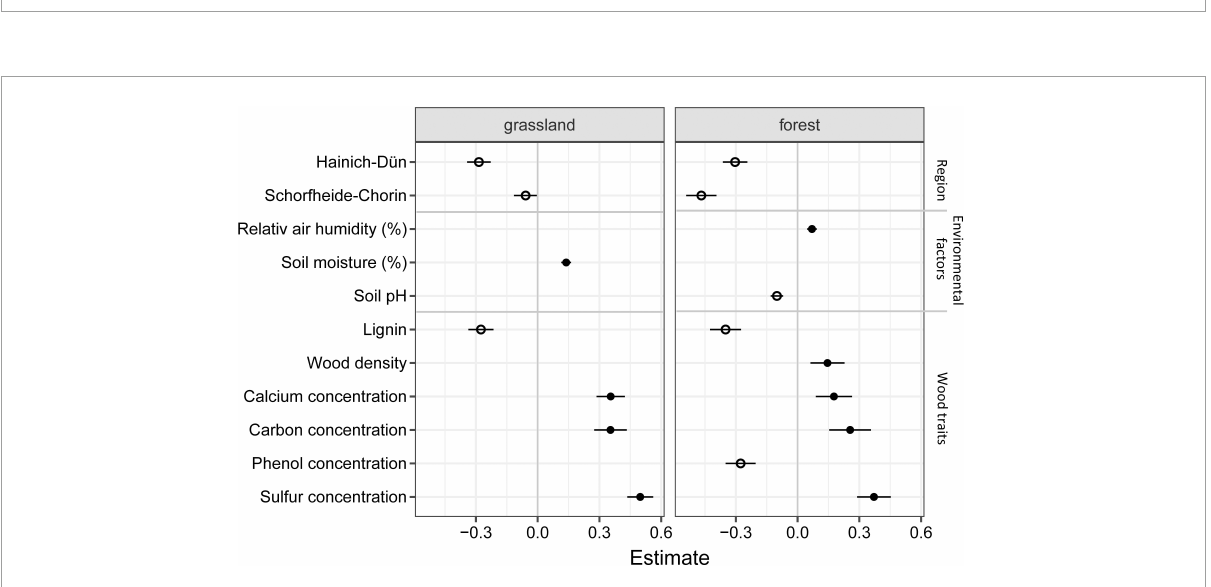
FIGURE4 Model estimates of the final linear mixed effect model (Model 2) to elucidate drivers of mass loss in forest and grassland habitats. Model-averaging procedure based on Akaike information criterion (AIC) and calculation for selection of importance factors (value > 0.75; details see Supplementary Figures 2–5 ). Effect mean size and confidence intervals are indicated for the parameters included in the model set (all models included). Detailed results of the final model are shown in Table 3